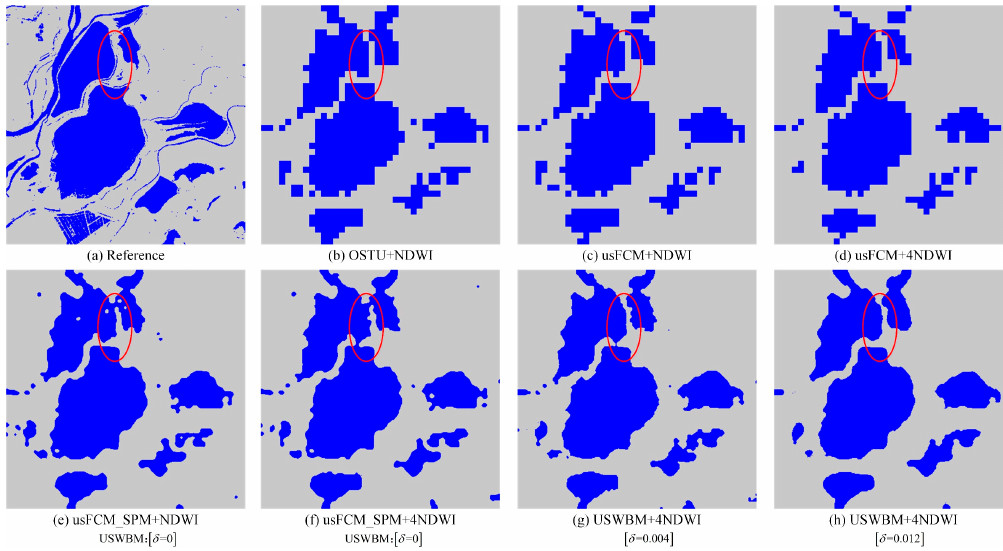
Figure 7. Water body maps generated by different algorithms for the Poyang lake. ( a ) Reference water body map; ( b ) Water body map produced from the NDWI image (based on NIR band 17) by using OSTU segmentation; ( c ) Water body map produced from the NDWI image by using usFCM segmentation; ( d ) Water body map produced from the four integrated NDWI images by using usFCM segmentation; ( e ) Water body map produced from the NDWI images by using usFCM_SPM segmentation; ( f ) Water body map produced from the four integrated NDWI images by using usFCM_SPM segmentation; ( g , h ) Water body map produced from the four integrated NDWI images by using the proposed USWBM algorithm when δ was 0.004 and 0.012,